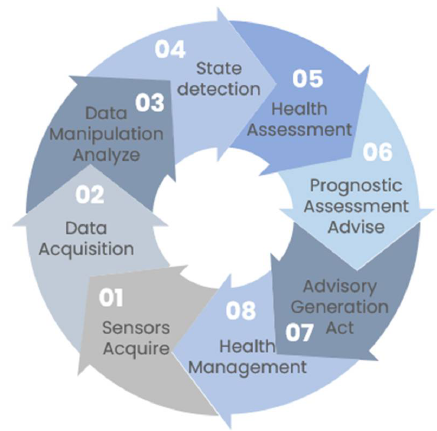
Figure 11. Steps in PHM [50].